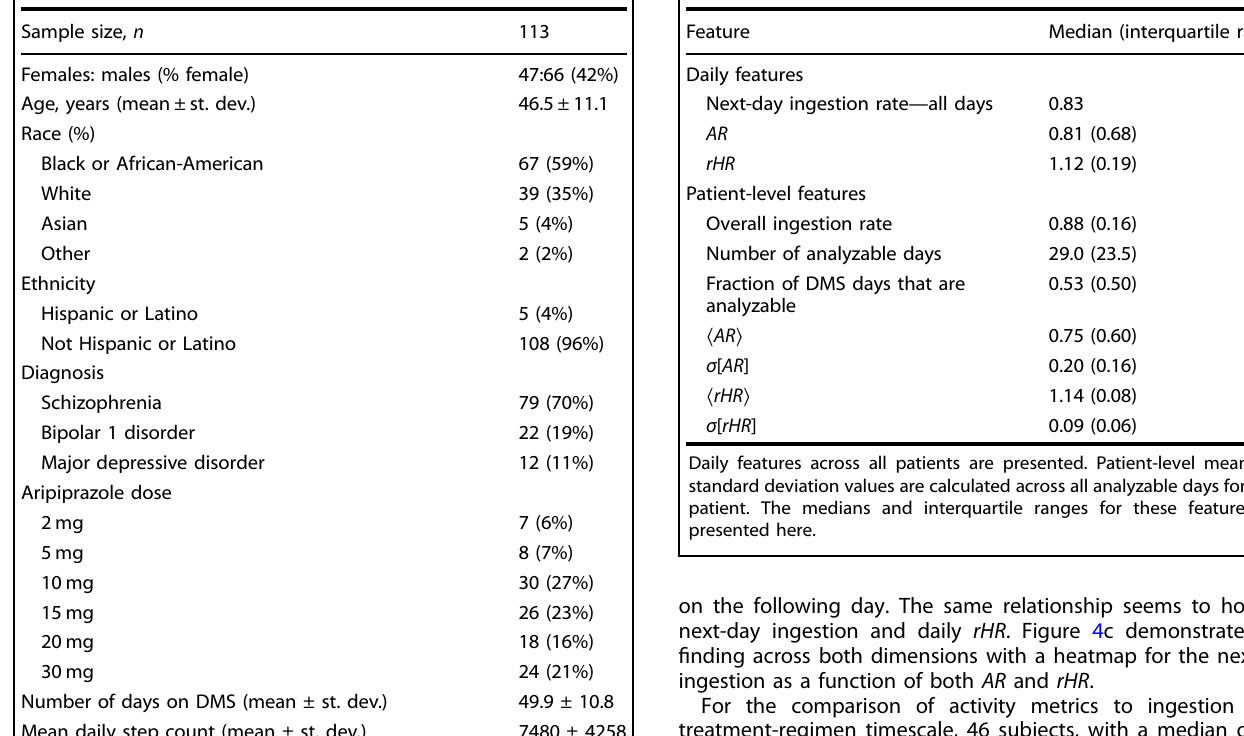
Table 1. Demographic and clinical characteristics of sample. Table 2. Feature